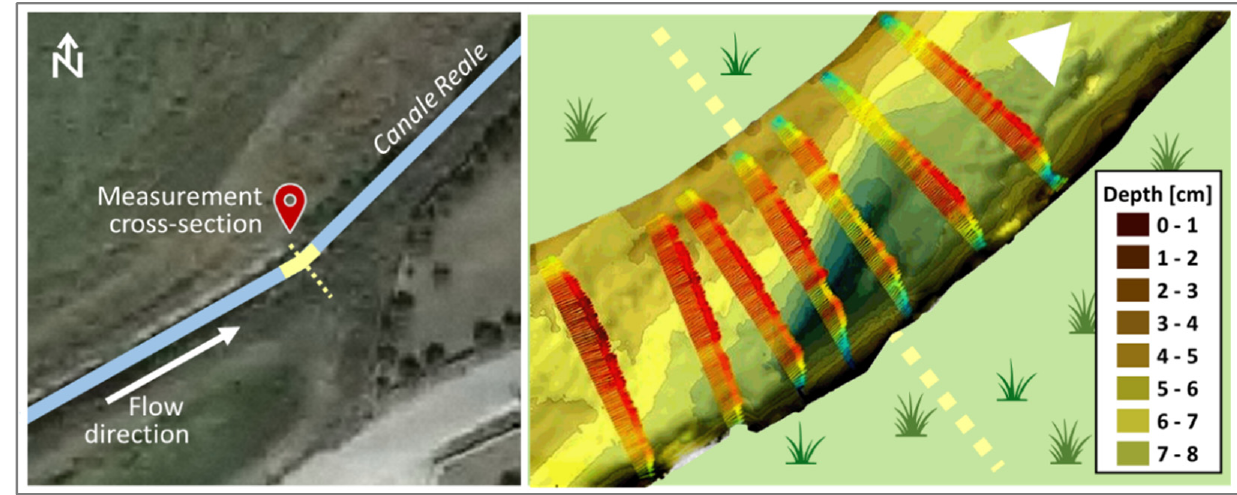
Figure 8. Detection of different layers and waves of the channel vs. depth for cross-section A.